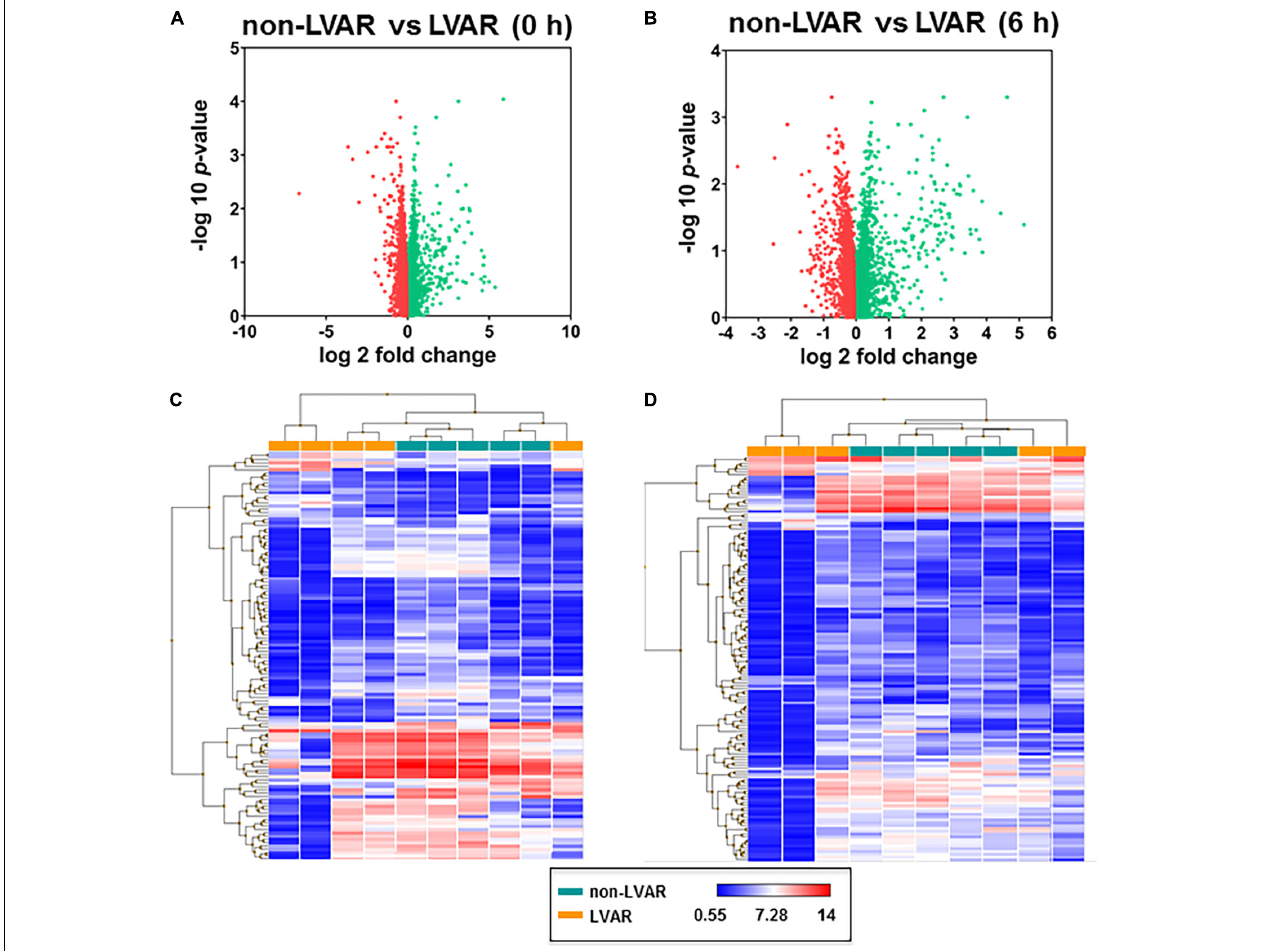
FIGURE 4 | miRNAs differentially expressed between non-LVAR and LVAR patients in PBMCs. (A,B) Volcano plots showing miRNAs differentially expressed in LVAR patients compared to non-LVAR patients at 0 h (A) and 6 h (B) after PPCI (Green dots: up-regulated miRNAs, red dots: down-regulated miRNAs). (C,D) Hierarchical clustered sample-centric heat-map plots of –2.5 > fold change > 2.5 value of miRNAs in PBMCs samples from non-LVAR (blue rectangle, n = 5) and LVAR patients (orange rectangle, n = 5) at 0 h (C) and 6h (D) . Scale bar, downregulated (blue) and upregulated (red). LVAR, left ventricle adverse remodeling; miRNAs, microRNAs; PBMCs, peripheral blood mononuclear cells; PPCI, primary percutaneous coronary